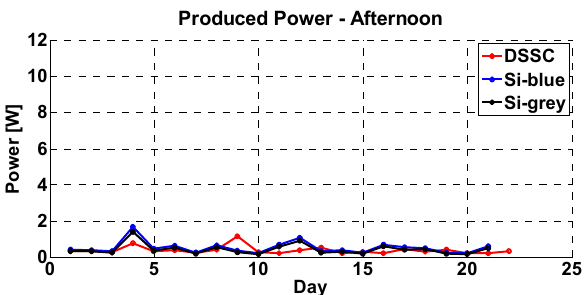
Figure 21. Morning power trends of the three generation systems.